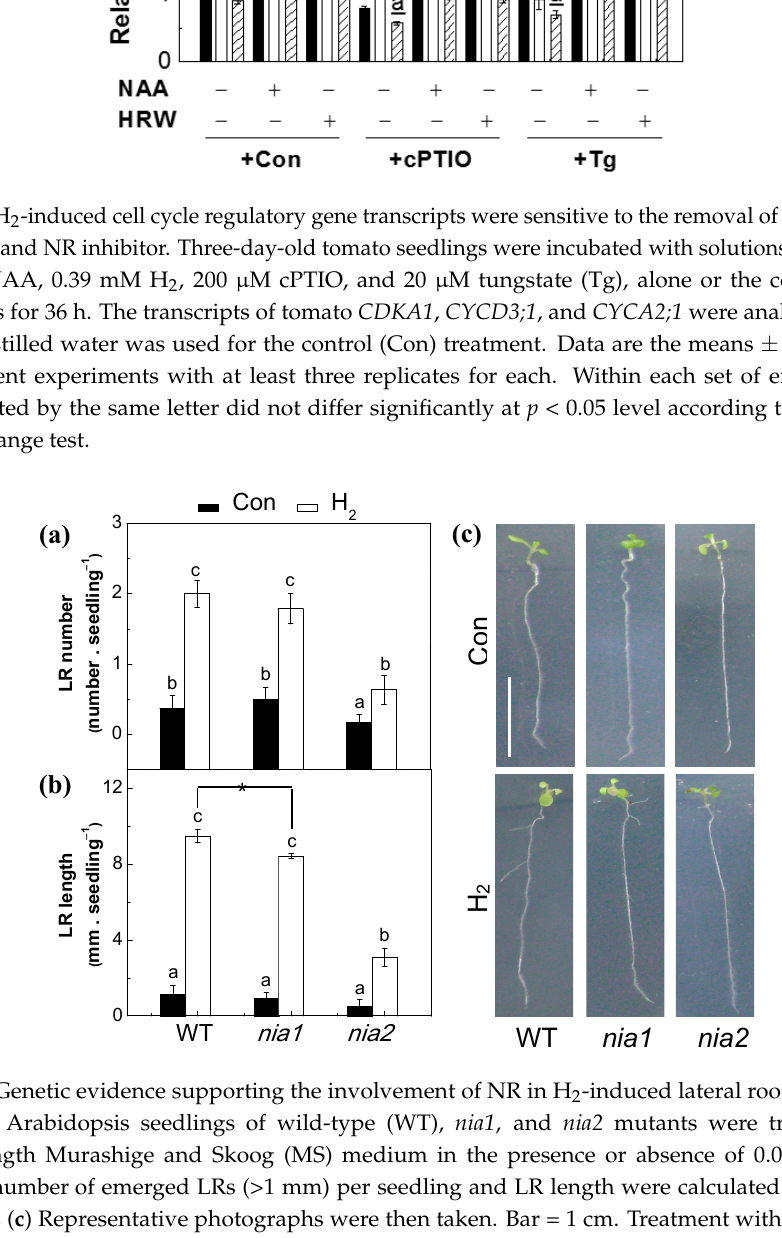
Figure 6. Genetic evidence supporting the involvement of NR in H 2 -induced lateral root formation. 7-day-old Arabidopsis seedlings of wild-type (WT), nia1 , and nia2 mutants were treated with semi-strength Murashige and Skoog (MS) medium in the presence or absence of 0.078 mM H 2 . ( a,b ) The number of emerged LRs (>1 mm) per seedling and LR length were calculated after 3-day treatment; ( c ) Representative photographs were then taken. Bar = 1 cm. Treatment without H 2 was regarded as control (Con). Data are the means ± SE of three independent experiments with at least three replicates for each ( n = 20). Within each set of experiments, bars denoted by the same letter or labeled with an asterisk did not differ significantly at p < 0.05 level according to Duncan’s multiple range